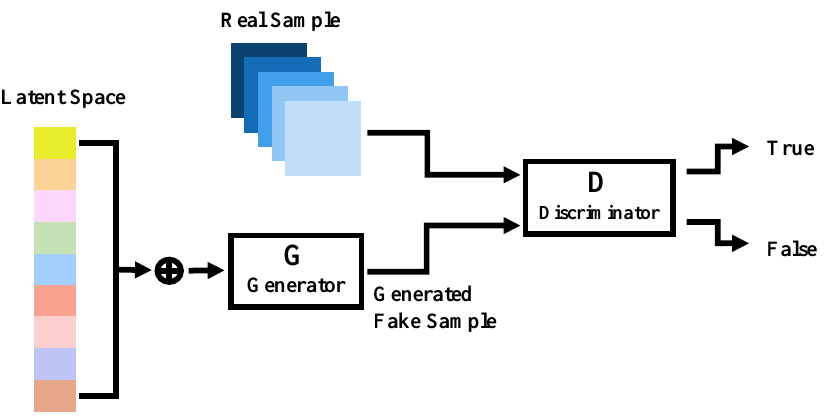
Figure 1. The framework of VAE.